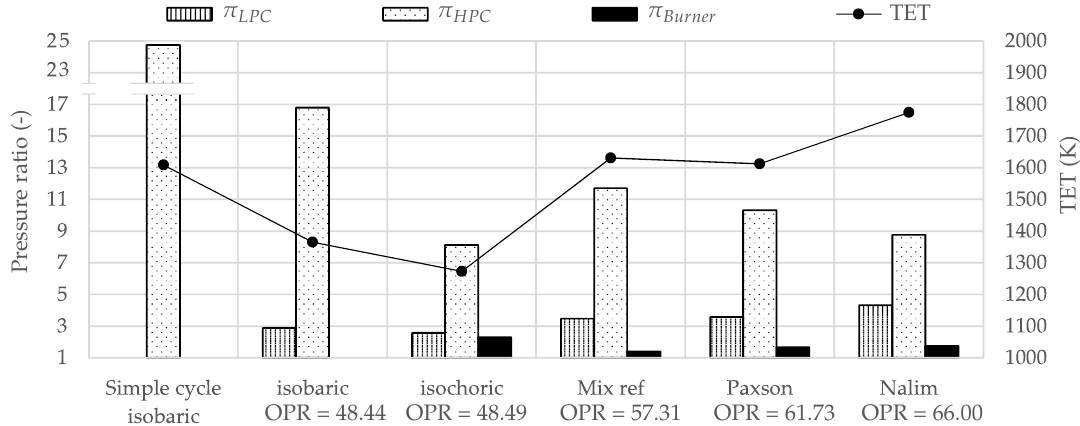
Figure 10. Pressure ratios and TET for the intercooled cycle. OPR, overall pressure ratio.